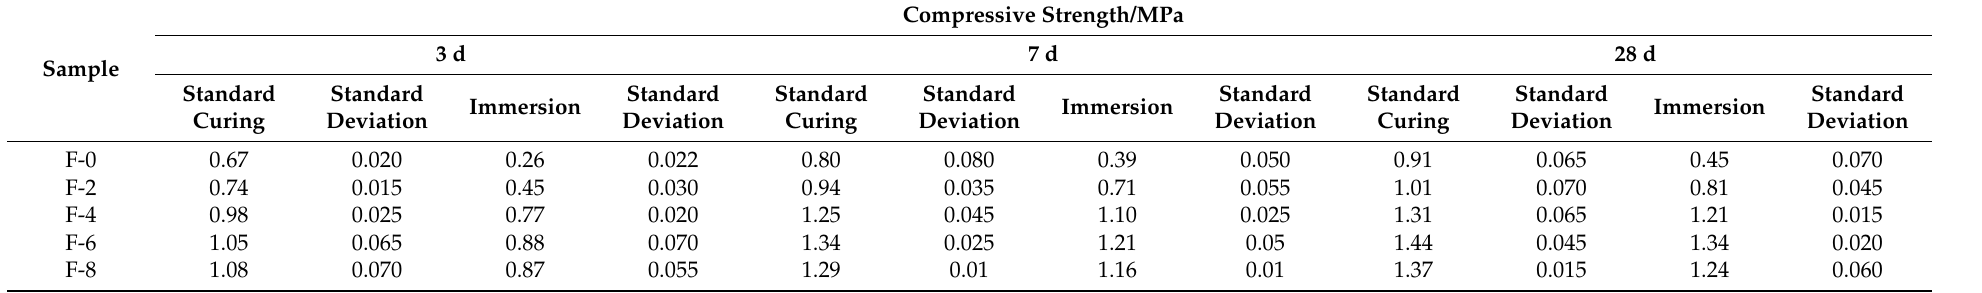
Table 6. Standard and immersion compressive strength values of all